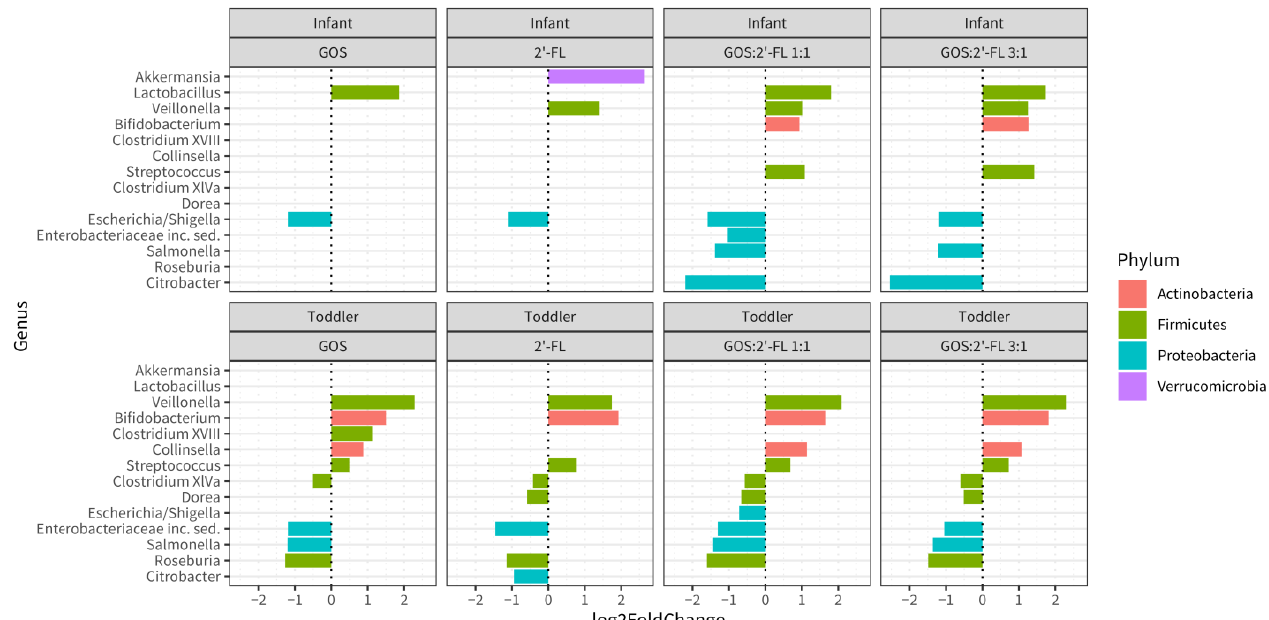
Figure 3. Barplots showing bacterial genera in samples of the micro-Matrix bioreactor batch fermen- tation experiments with significant differential relative abundance expressed as log2fold change between fermentations, with the indicated oligosaccharides and the control without oligosaccharides in the infant ( top ) and toddler ( bottom ) populations. Note that, outcomes from fermentations with the two dosages were compiled together and regarded as one treatment. Significance was tested by Wald test after fitting a negative binomial generalized linear model for each observed genus using the DESeq2 method.